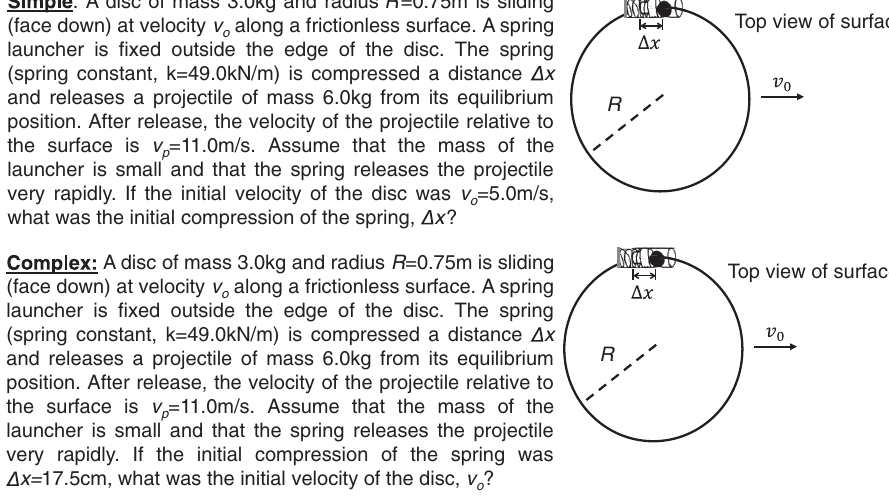
FIG. 4. The two versions of the simultaneous synthesis problem.